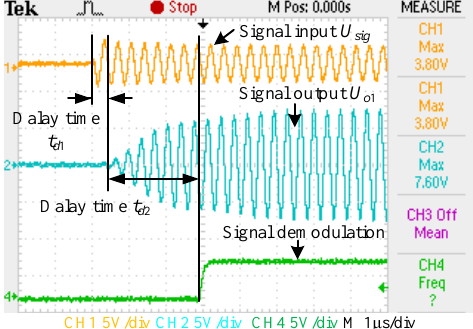
Figure 17. Delay time of data transmission.